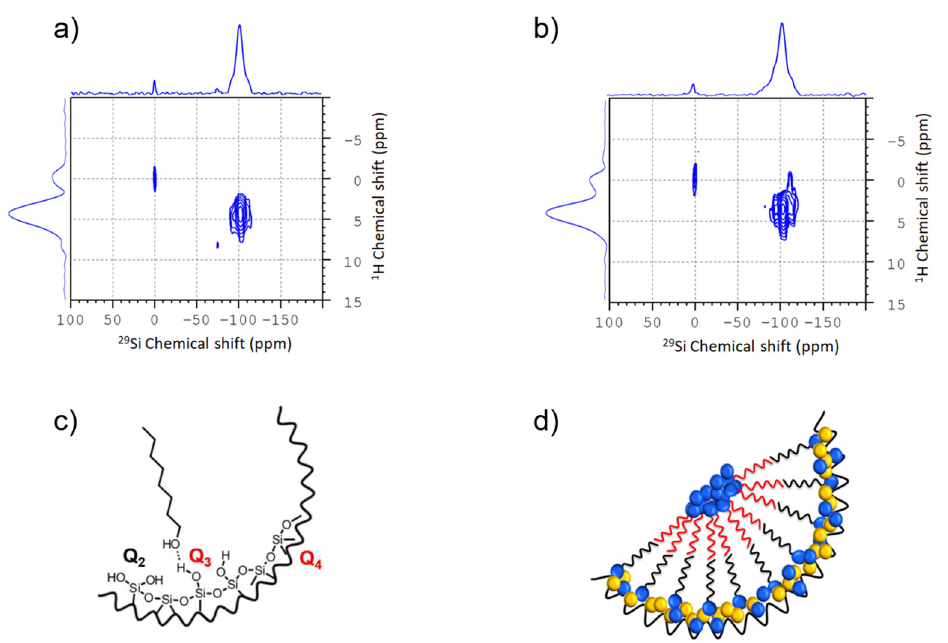
Figure 8. Upper panel: Room temperature 1 H- 29 Si CPMAS FSLG-HETCOR experiment measured at 8 kHz spinning of dried SBA-15 filled with a mixture of 80:20 mol% of 1-octanol and water with a contact time of ( a ) 3 ms and ( b ) 9 ms. Lower panel: ( c ) schematic models for interactions of the pore surface of SBA-15 with 1-octanol. ( d ) Graphical visualization of a feasible bilayer formation of 1-octanol inside the pore. Water molecules are concentrated near the pore wall as well as in the pore center. The intermediated area between pore wall and pore center is occupied by the aliphatic hydrophobic chains of the 1-octanol molecules (adapted from Kumari et al. [203]).